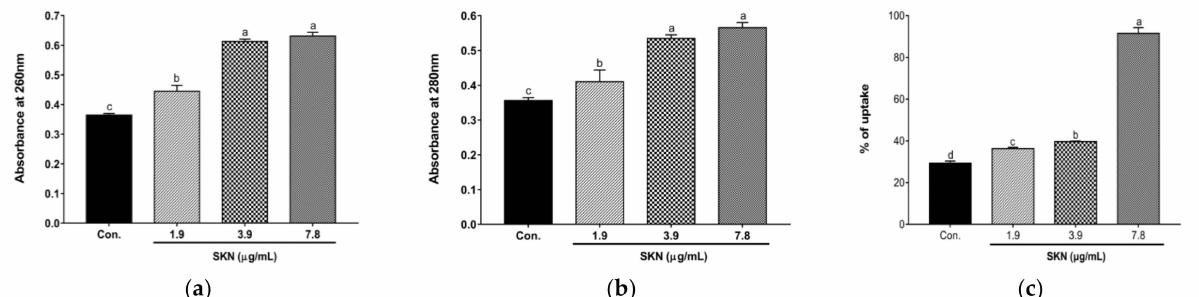
Figure 3. Cell contents release determined by measuring absorbance at 260 nm ( a ) and 280 nm ( b ) in DPS-1 strains treated with SKN. ( c ) Bacteriolytic effects of SKN against DPS-1. The data are means ± SD of triplicate determinations. Different letters on the bars indicate significant statistical differences between treatments ( p < 0.05), while the same letters mean no significant differences ( p >